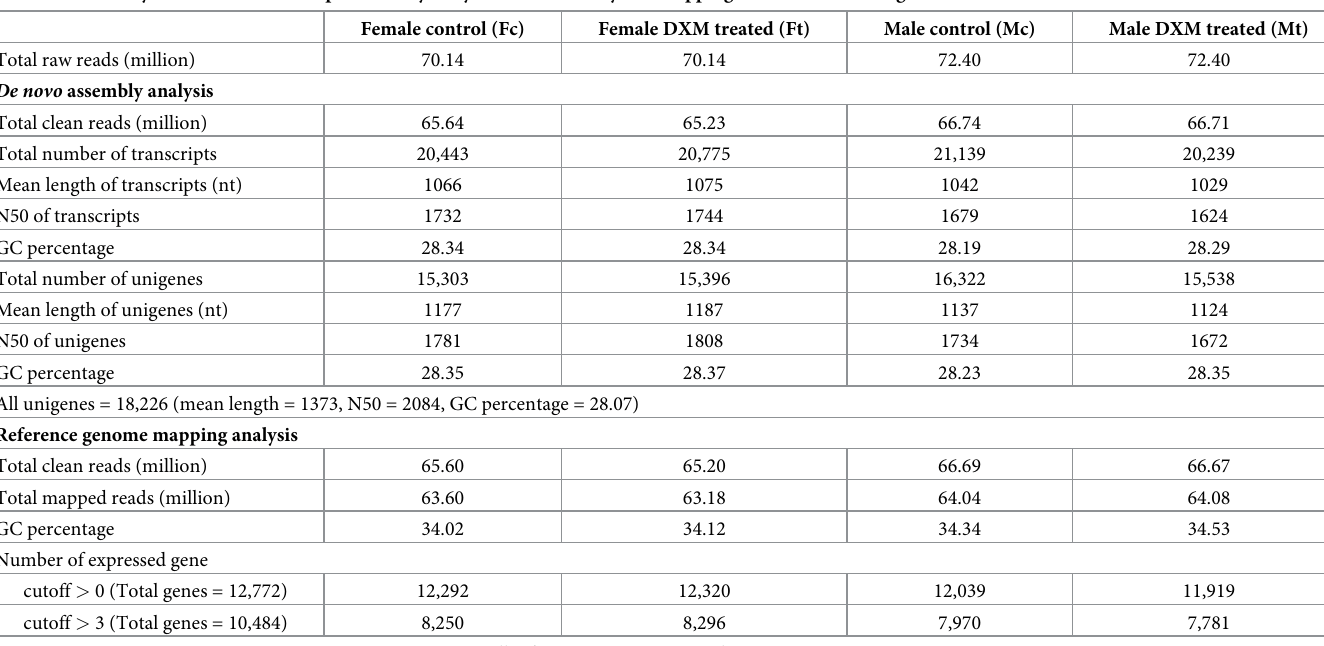
Table 2. Summary statistics for transcriptome analysis by de novo assembly and mapping to the S . stercoralis